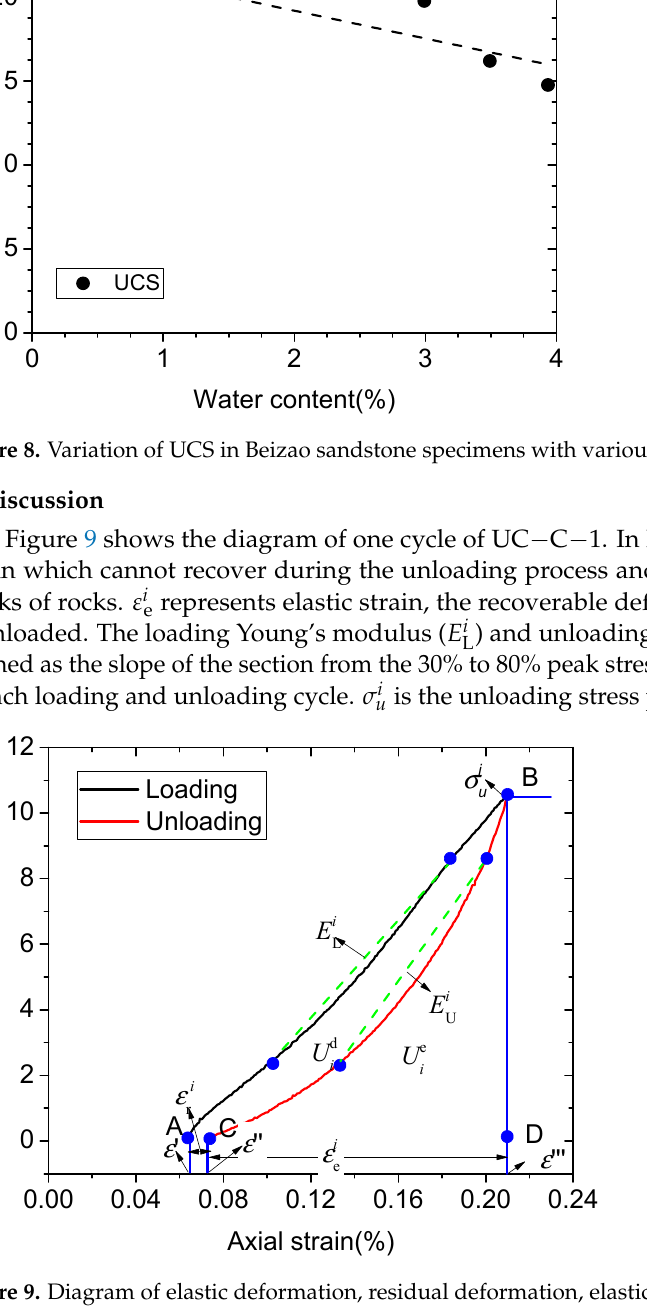
Figure 7. Stress-strain curves of the Beizao sandstone with different water content: ( a )